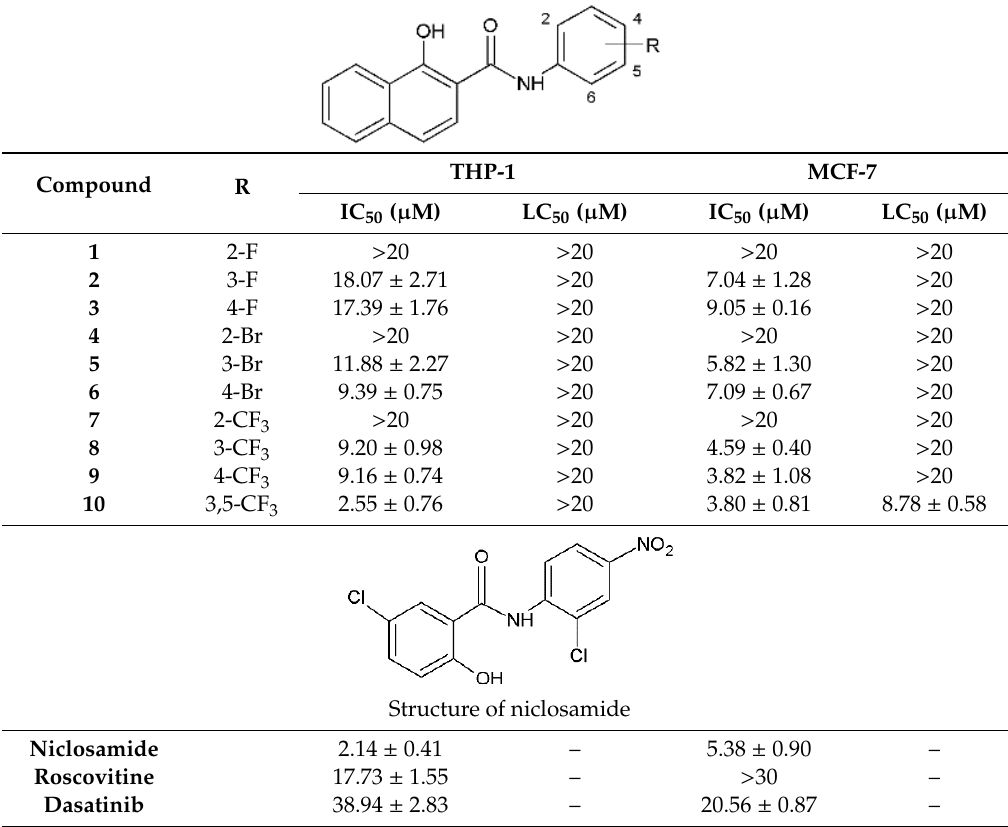
THP-1 MCF-7 Compound R IC 50 ( µ M) LC 50 ( µ M) IC 50 ( µ M) LC 50 ( µ M) 1 2-F